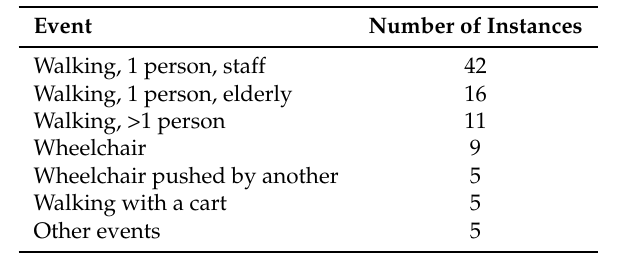
Table 1. Number of instances in the dataset. Signals have an average duration of 10 s. Note that in the walking, >1 person category, all the walkers were either all elderly or all medical staff.